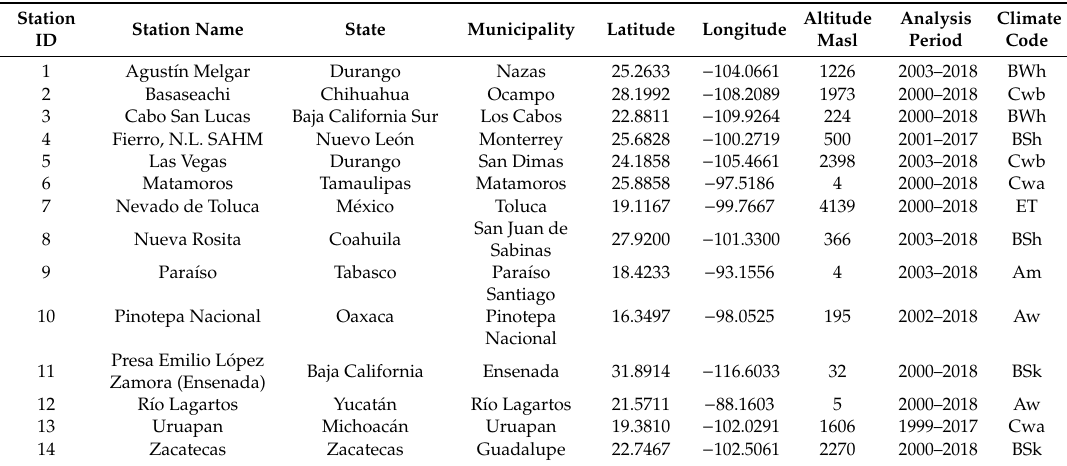
Table 1. Detailed information of the weather